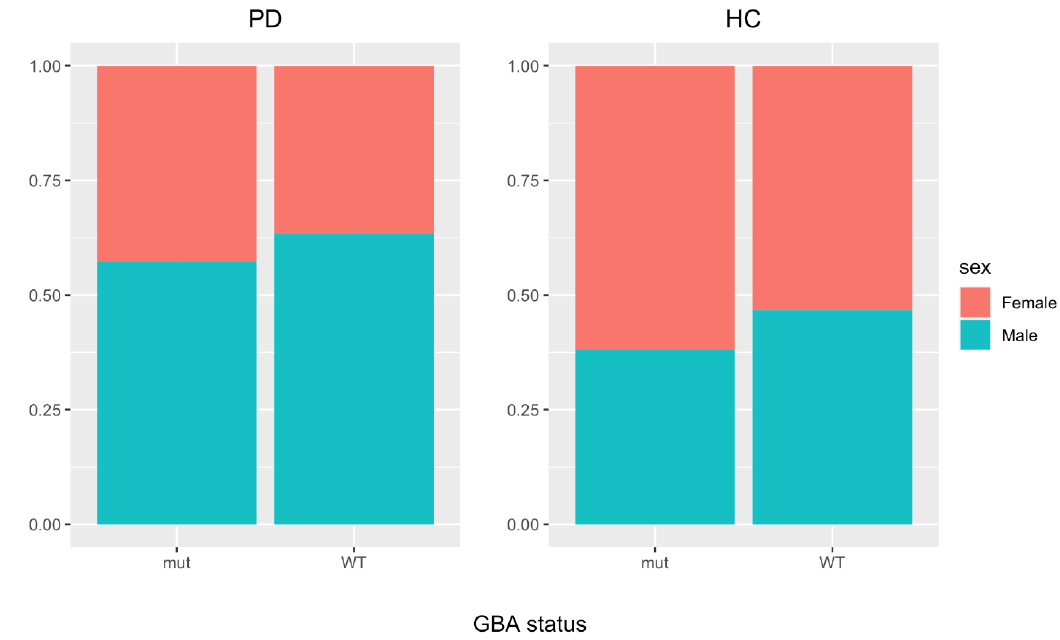
Figure 7. Different sex distribution in idiopathic-PD and GBA-PD patients. The plot summarizes the ratio of females and males in PD and healthy control (HC) populations; mut = mutant.